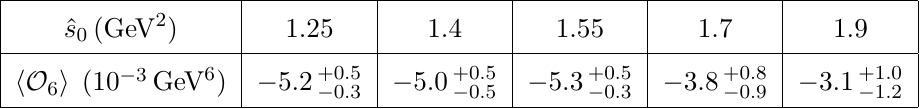
Figure 6 . Distribution for hO 6 i obtained with the tuples procedure at ˆ s 0 = 1 . 7 GeV 2 .